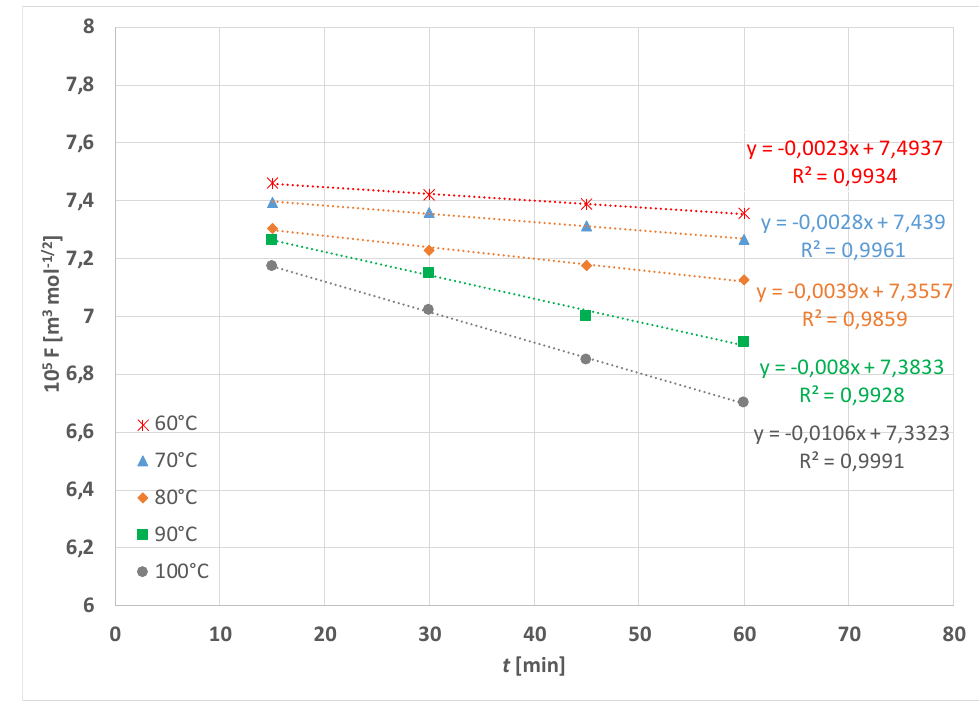
Figure 7. Theoretical function F vs. time t for hydrolysis in 1.5 mol cm − 3 NaOH at temperature range 60 to 100 °C according to Equations (4) and (5).